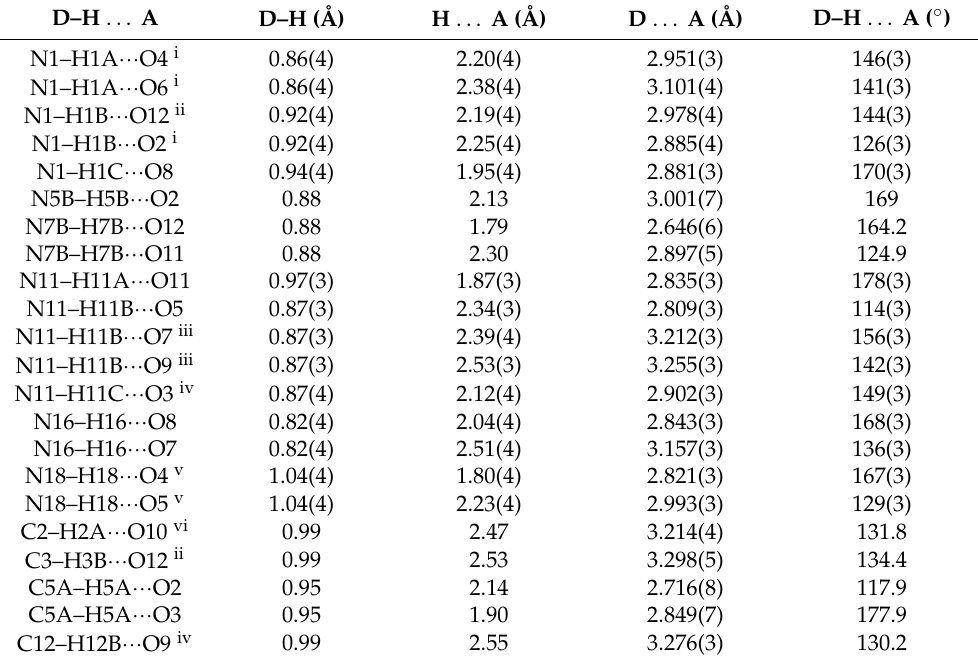
Table 3. Geometry of hydrogen bonds (Å, ◦ ) in